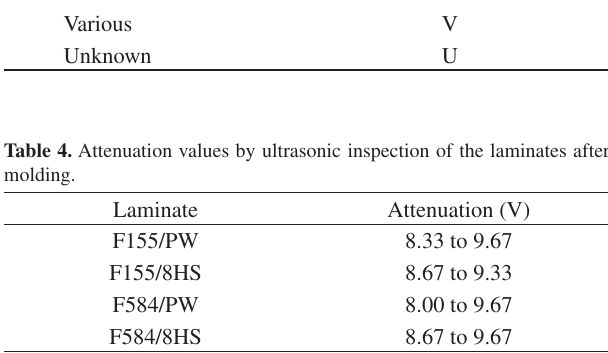
Figure 3. Typical C-Scan ultrasonic images after laminates